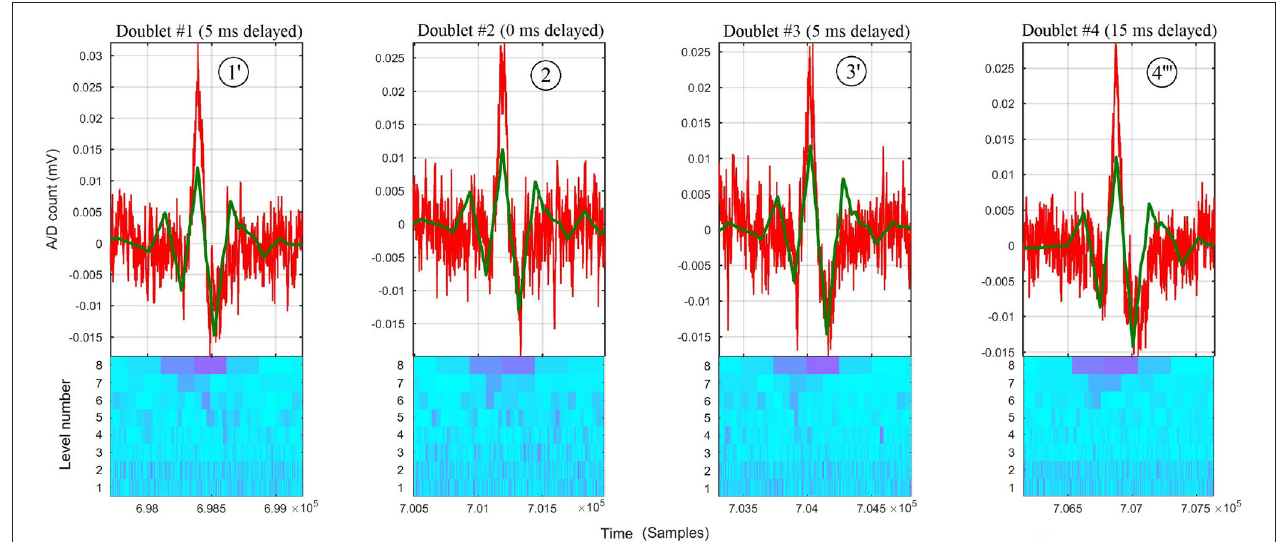
FIGURE 5 | Zoom around each burst of raw thoracic sEMG trace (in red) of subject #4, overlaid with its 8-level sub-signal (in green) and its scalogram below (Conventions are the same as in Figure 1 ) . The D8 doublets #1’, #2, #3’, and #4”’ correspond to time-shifting the DWT at their respective Pareto front time delays of 5, 0, 5, and 15 ms, resp., obtained for each doublet by the expert system.